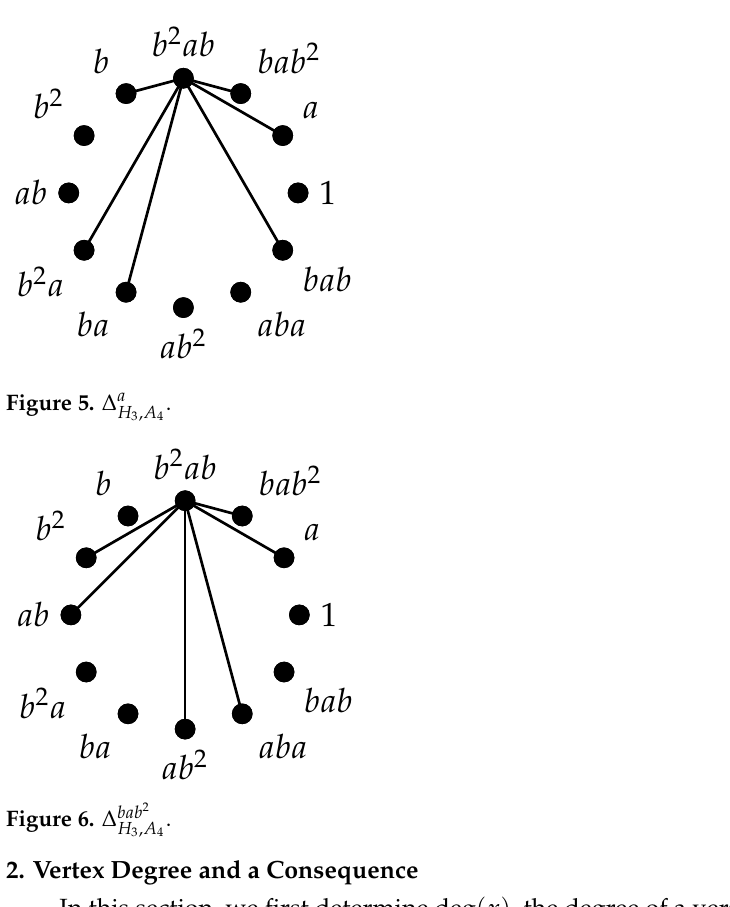
2 ab H 1 , A 4 H 2 , A 4